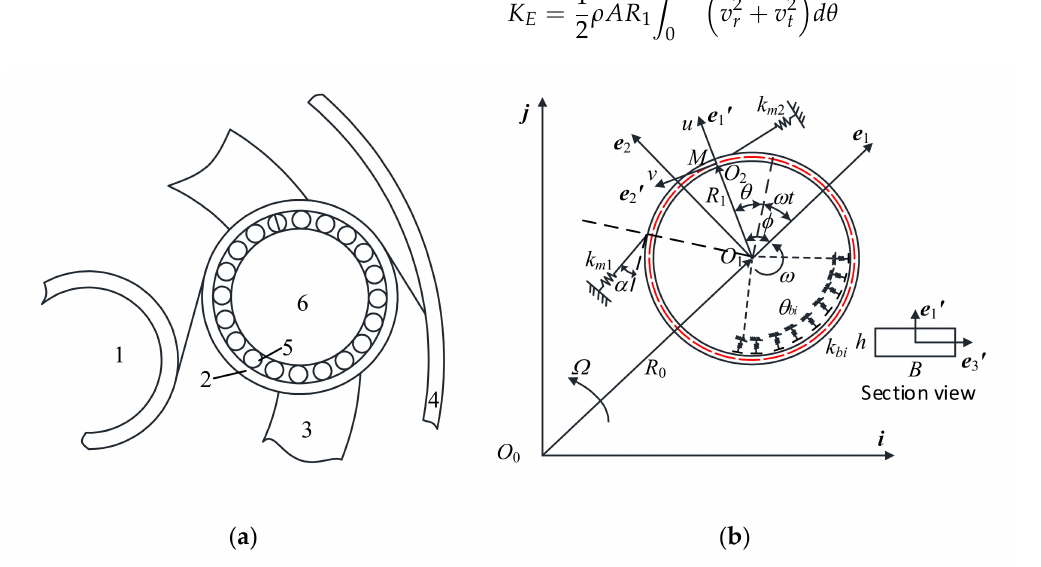
Figure 1. Schematic of planetary gear set: ( a ) physical model, 1—sun gear, 2—planet gear, 3—carrier, 4—ring gear, 5—bearing, 6—planet gear shaft; ( b ) vibration model of a planet